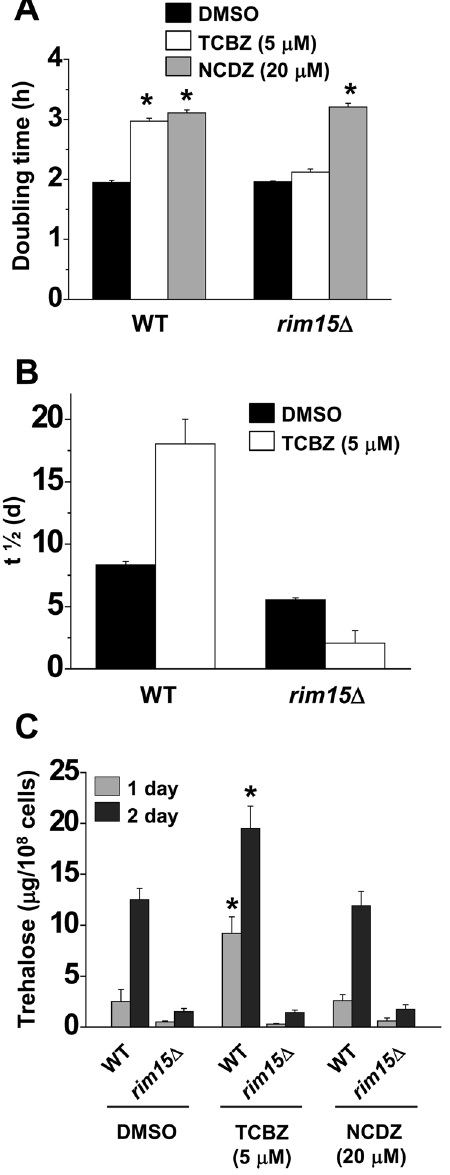
Figure 7. Rim15 is required for triclabendazole biological activity. (A) Doubling time. Cells (wild-type, WT, or rim15 D ) were inoculated in SC-glucose medium with the indicated drug or DMSO and incubated at 30 u C with shaking. Doubling time values are the mean 6 SD of the three independent experiments. *, p , 0.001 (versus DMSO). (B) Chronological aging. Cells were inoculated in SC-glucose medium with drug or DMSO and incubated at 30 u C with shaking for 48 h (= zero point for survival curve). Survival curves give the percent of viable cells over time. Values are the mean 6 SD of the three independent experiments. (C) Trehalose accumulation. Cells were inoculated in SC- glucose medium with drug or DMSO, incubated at 30 u C, and at the indicated time the trehalose content was determined. Values are the mean 6 SD of the three independent experiments. *, p , 0.01 (versus DMSO). Triclabendazole, TCBZ; nocodazole, NCDZ.